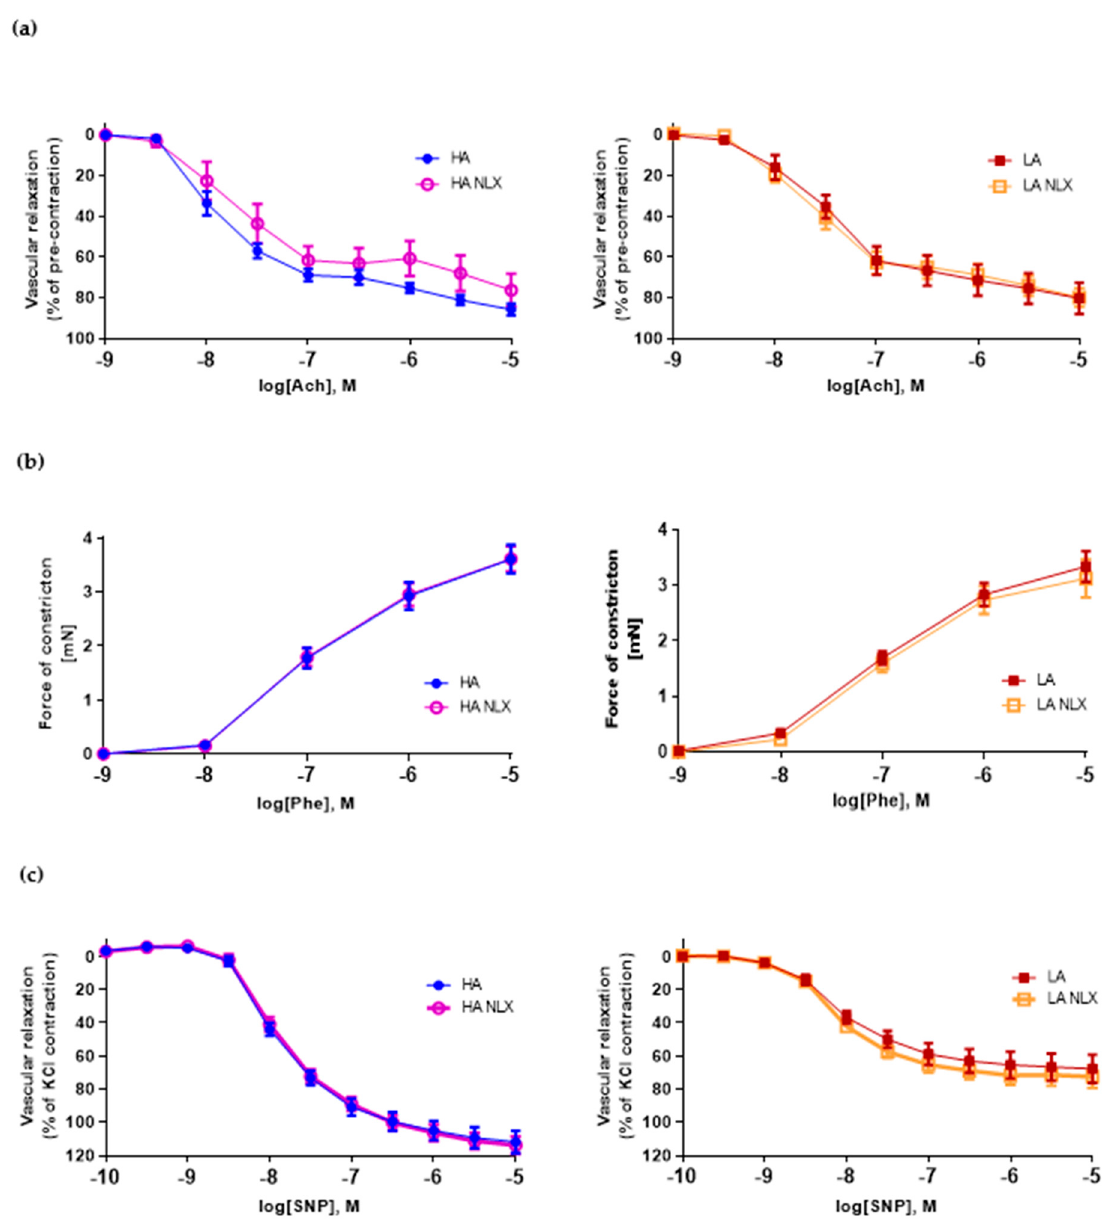
Figure 5. ( a ) Vascular relaxation of aortas from HA and LA mice and aortas treated in vitro with naloxone in response